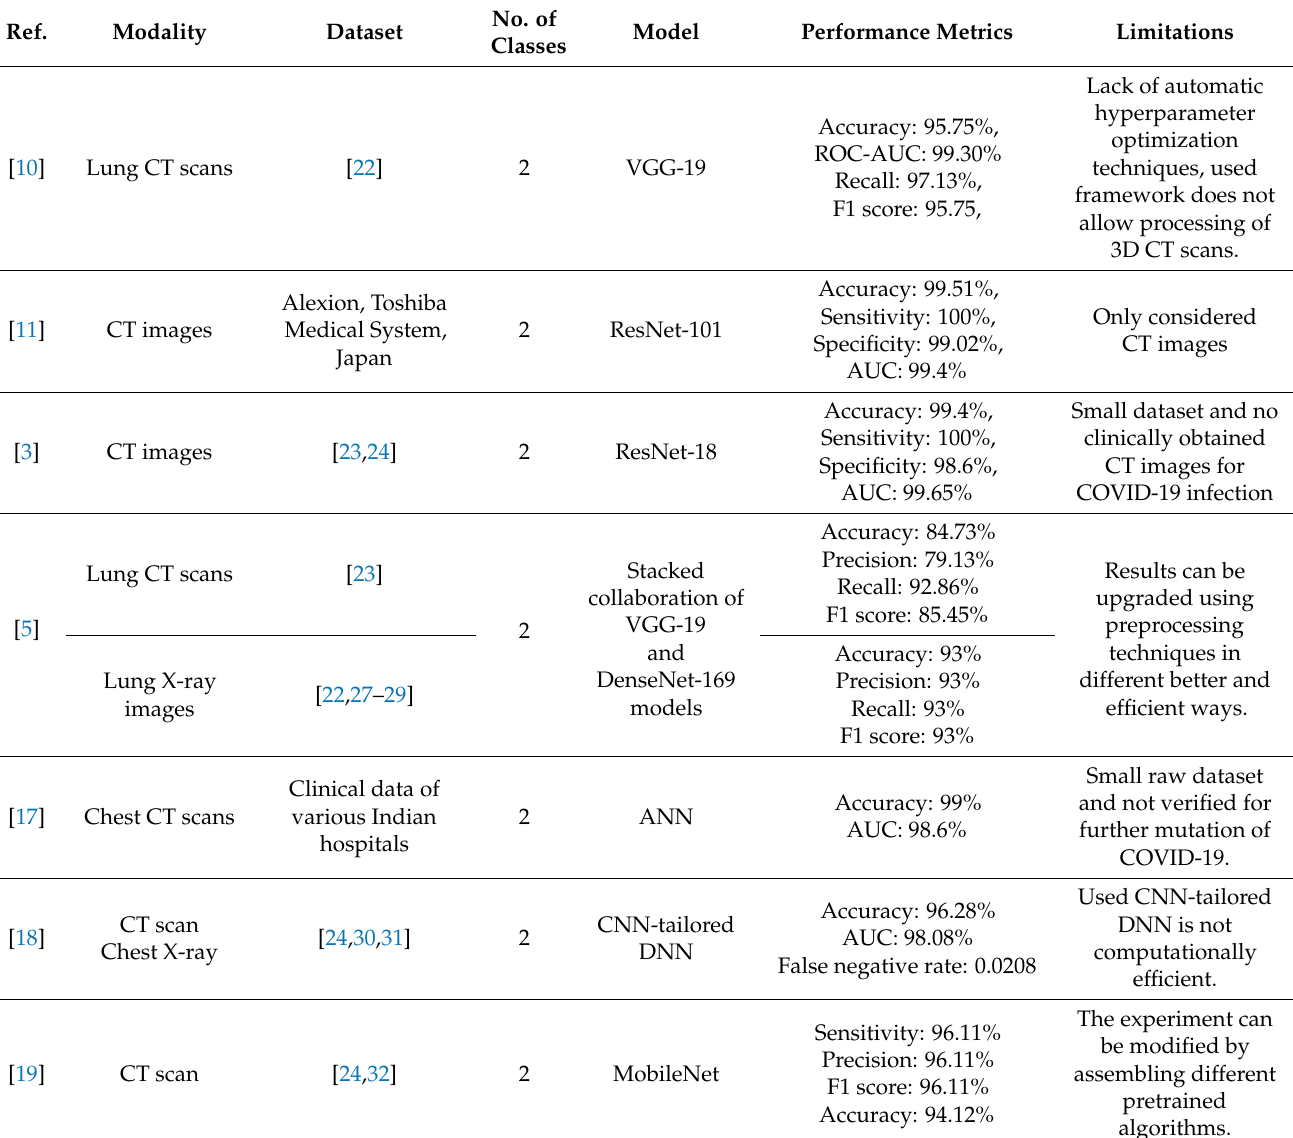
Table 1. Summary of the literature